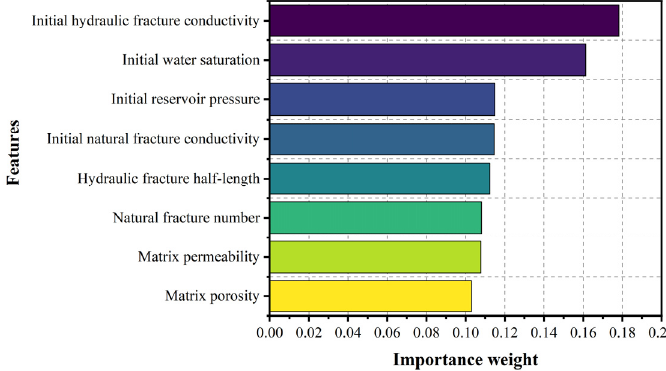
Figure 10. Production with different natural fracture conductivity values.